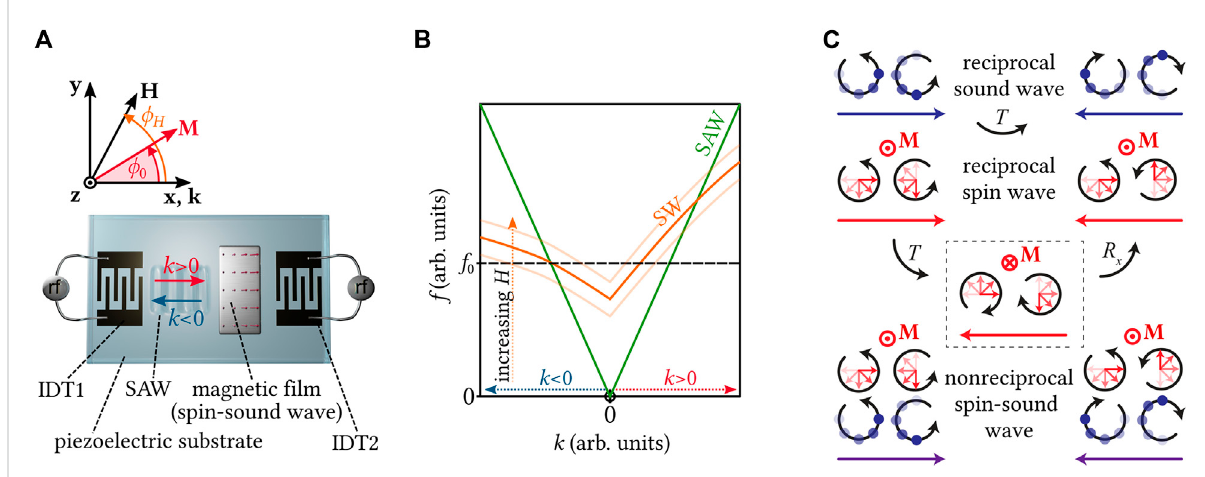
FIGURE 1 (A) Illustration of the investigated piezoelectric-ferromagnetic hybrid device. Nonreciprocal effects are characterized by studying the transmission of counter-propagating SAWs with wave vectors k > 0 and k < 0. (B) The dispersion relation is reciprocal for SAWs but can be nonreciprocal for SWs because of dissimilar interfaces on the opposite sides of the magnetic thin fi lm. If the SAW is excited at a fi xed frequency f 0 (dashed line), resonant SAW-SW coupling is only possible for the magnetoacoustic waves propagating to the left side ( k < 0), and a large nonreciprocal transmission is expected. The SW dispersion is tuned by the magnitude H and angle ϕ H of the external magnetic fi eld. (C) Nonreciprocal spin-sound waves can arise from the interaction of individually reciprocal sound and spin waves. The lattice motion (magnetization precession) at two different lattice sites along the x-axis propagation direction of the sound wave (spin wave) is schematically depicted by the blue dots (red arrows) and the black circles represent the circular motion and its phase shift. The reciprocal counter-propagating waves can be transformed into each other by time reversal T and rotation R x operations. No symmetry operation exists for the nonreciprocal spin-sound